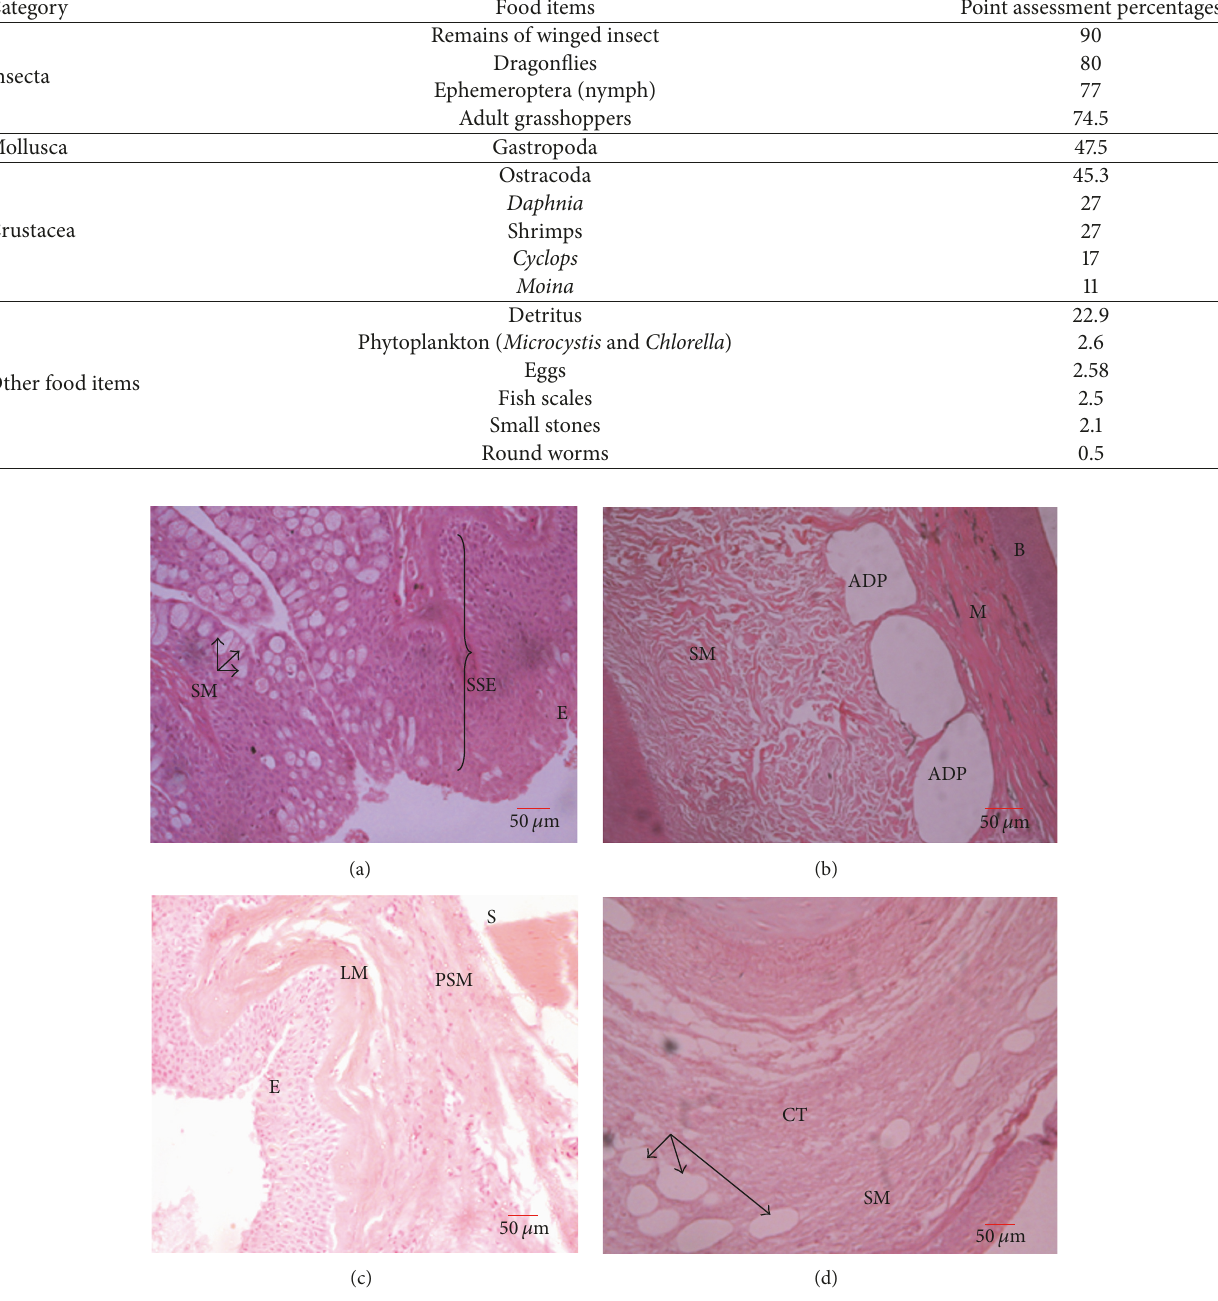
Figure 5: Oral cavity. (a) Lips: skeletal muscles (SM) and stratified squamous epithelium (SSE) with goblet cells (arrows). (b) Palate-roof of the oral cavity: epithelium (E), submucosa (SM) with irregular connective tissue, adipose tissue (ADP), skeletal muscle (M), and underlying bone (B). (c) Floor of the oral cavity: epithelium (E), laminar muscularis (LM), propria submucosa (PSM), and skeletal muscle (SM). (d) Tongue: adipose tissue (arrows), skeletal muscle (SM), connective tissue (CT), and underlying cartilage